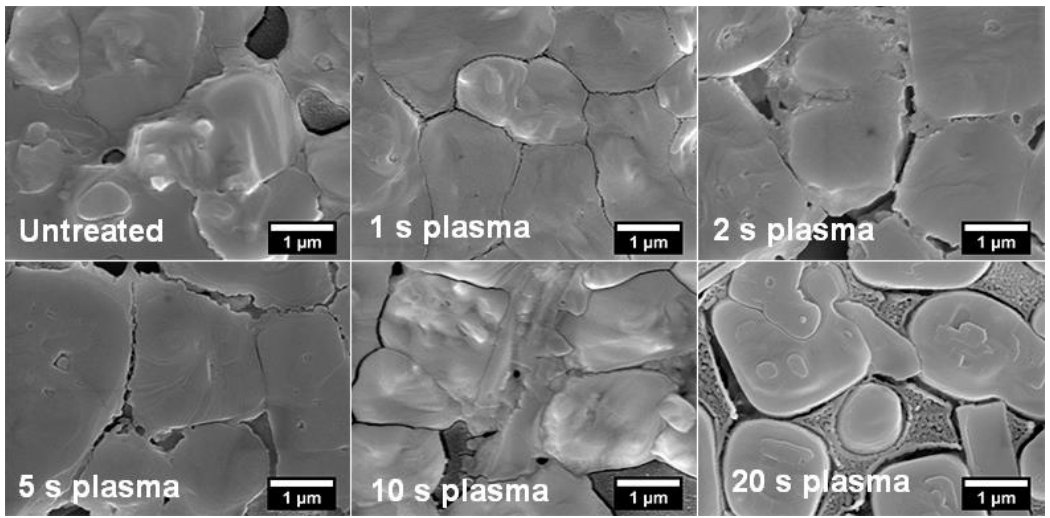
Figure 6. SEM images of mixed-halide perovskite films before and after plasma treatment. Table 1. Average grain size of the mixed-halide perovskite films before and after plasma treatment. Sample Grain Size (µm)